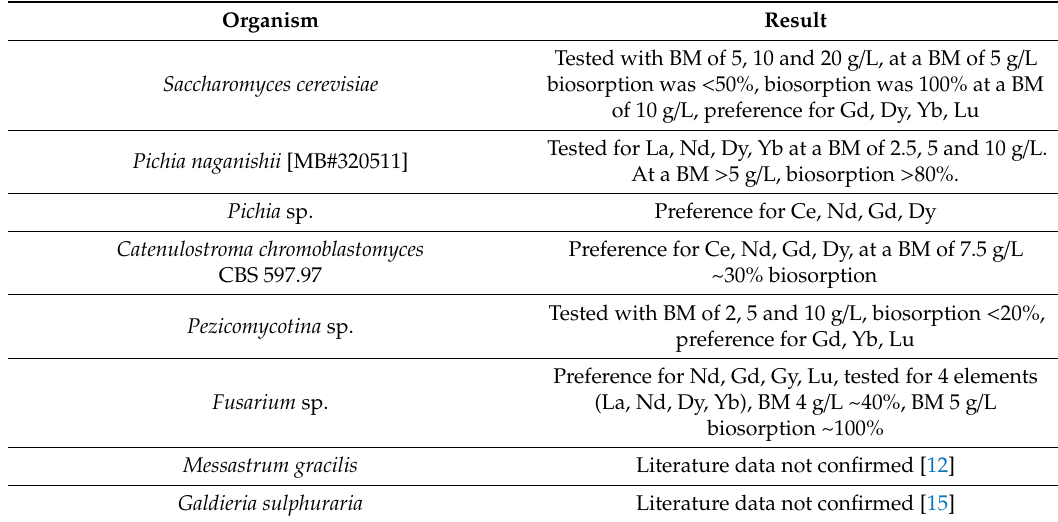
Table 2. Overview about biosorption capabilities of